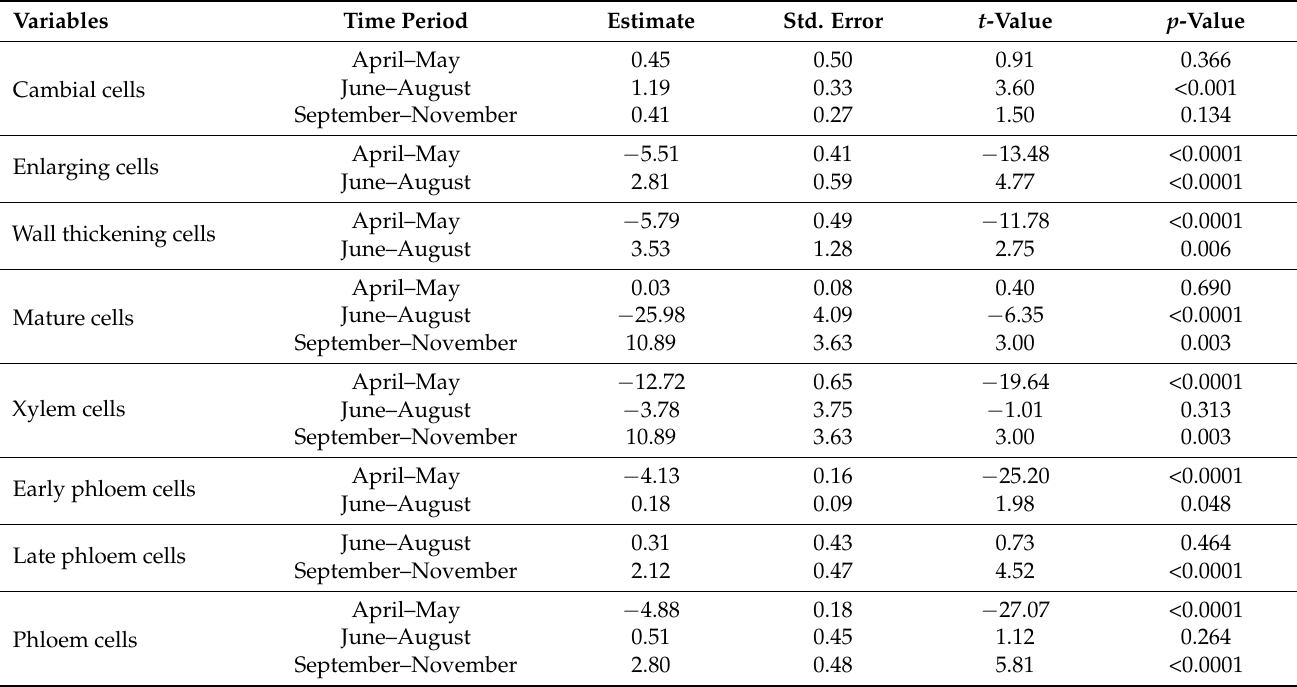
Table 4. Comparison of the intra-annual xylem and phloem formation of Picea crassifolia between sampling sites using linear mixed-effects